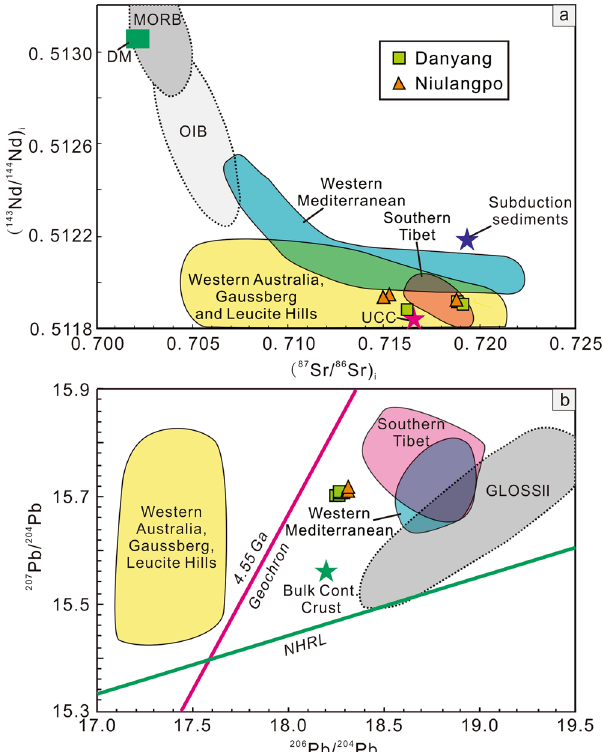
Figure 3. Plot of ( 143 Nd/ 144 Nd) i vs. ( 87 Sr/ 86 Sr) i and 207 Pb/ 204 Pb vs. 206 Pb/ 204 Pb for the studied lamprophyres. Data sources: Western Mediterranean lamproites 11 , Southern Tibet potassic rocks 10 , lamproites from